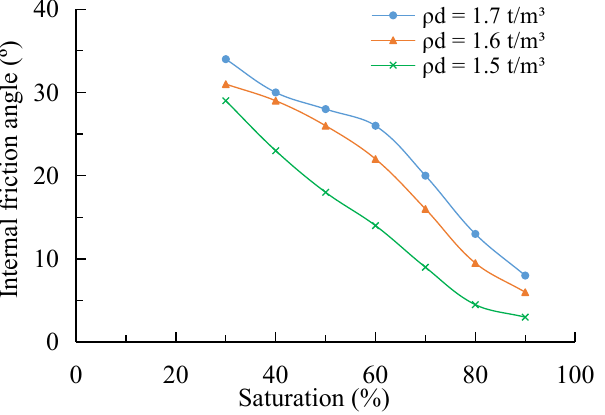
Figure 14. Experimental points of the relationship between the internal friction angle and saturation.